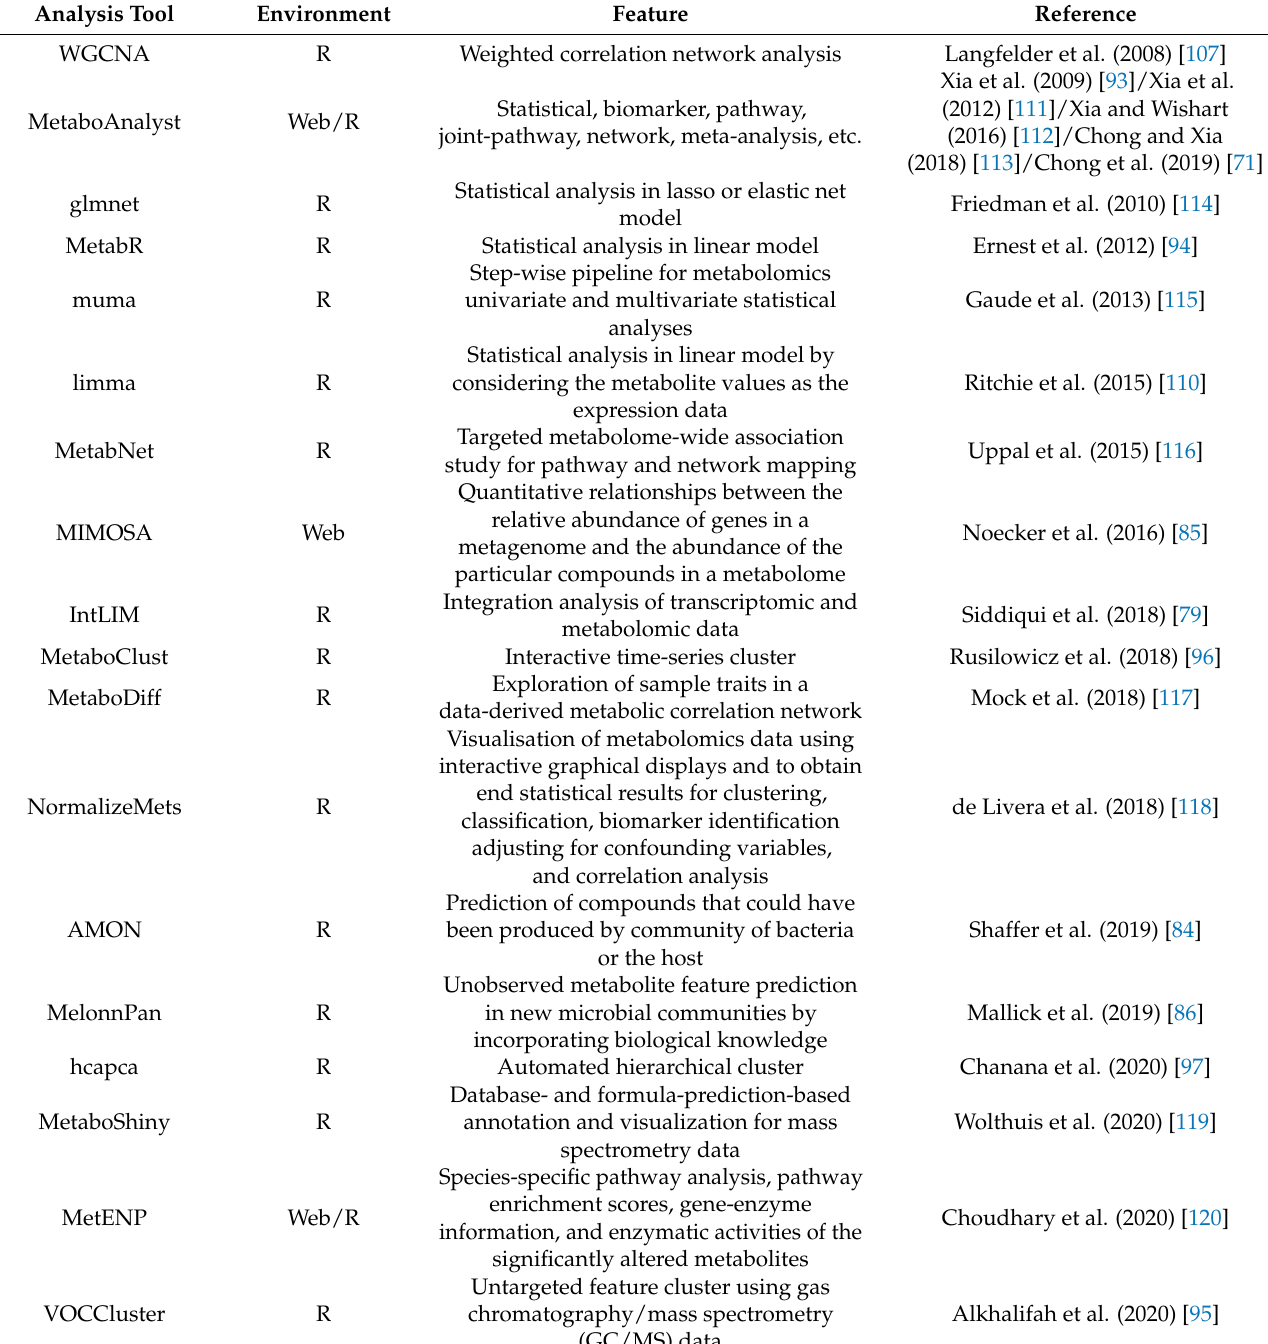
Table 2. Metabolomics analysis tools and their